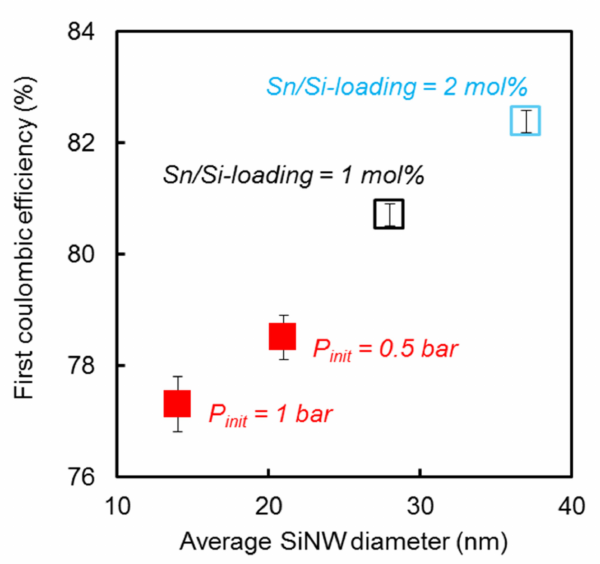
Figure 4. First Coulombic efficiency as a function of the SiNW average diameter for SiGt obtained by varying Sn/Si loading (empty squares, P init = 50 mbar) and by varying the initial argon pressure P init (full squares, Sn/Si loading = 1 mol%).